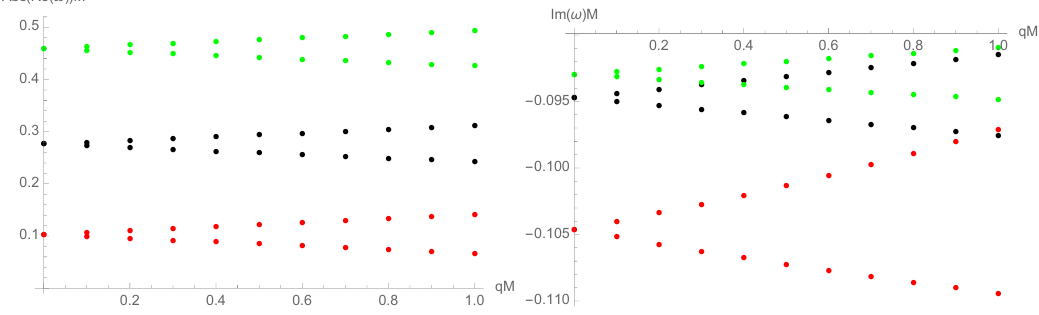
Figure 4 . The two branches of the photon sphere modes for massless scalar fields. Left panel for the behaviour of | Re ( ω ) | M , and right panels for Im ( ω ) M , as a function of qM for ‘ = 0 (red points), ‘ = 1 (black points), and ‘ = 2 (green points) with Λ M 2 = 0 . 01 , and Q/M = 0 . 1